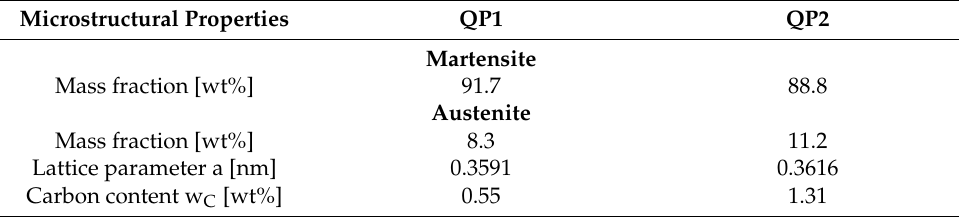
Table 2. Mass fraction and lattice parameters of the phases of the QP1 and QP2 conditions.